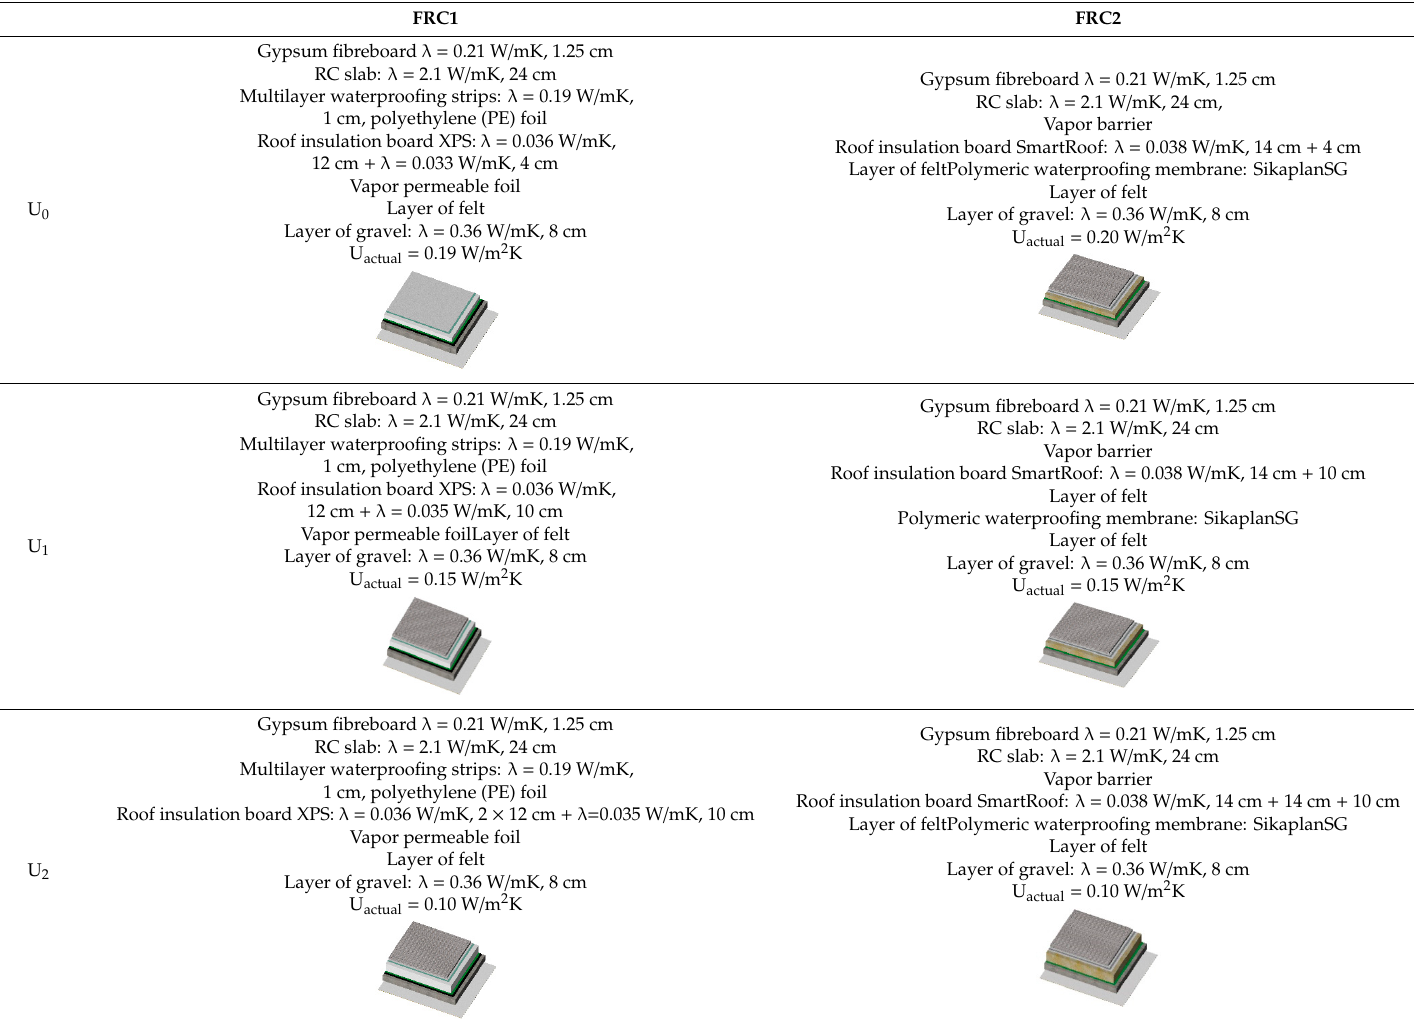
Table 2. The comparison of the analysed roof components.